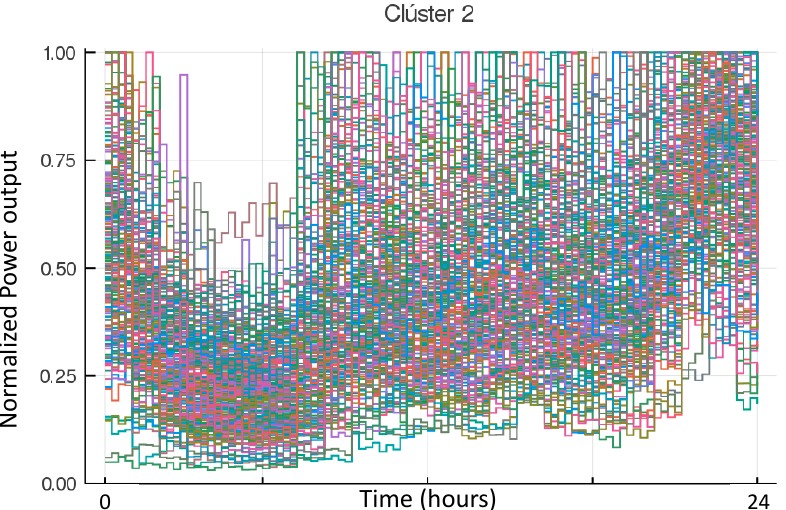
Figure 6. Data of 362 actual distribution customers from Santiago, Chile. Cluster 1.